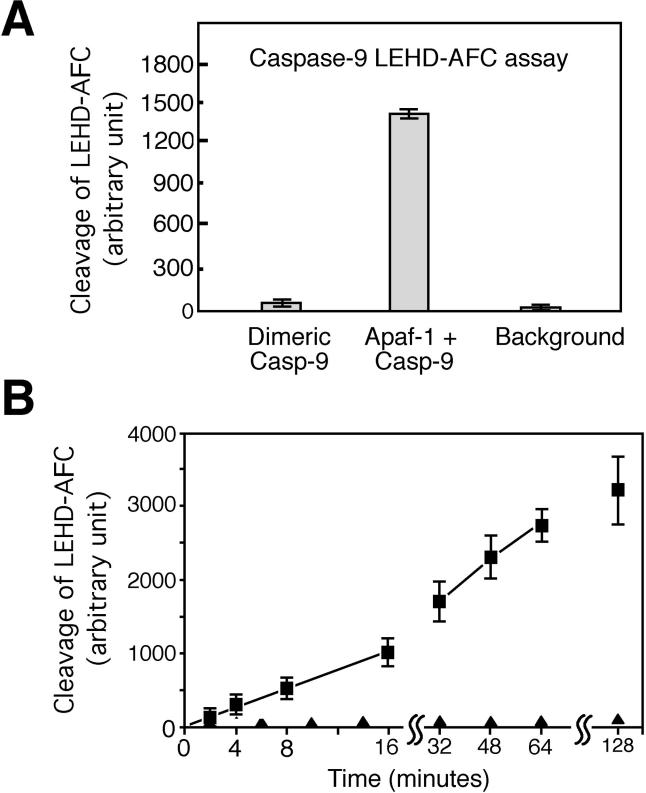
The Dimeric Caspase-9 Exhibits a Much Lower Activity Than the Apaf-1-Activated WT Caspase-9(A) Using fluorescent substrate LEHD-AFC, the catalytic activity of the Apaf-1-activated WT caspase-9 was approximately 35-fold greater than that of the dimeric caspase-9.(B) A time course comparison of the catalytic activities between the Apaf-1-activated WT caspase-9 and the dimeric caspase-9. WT and dimeric caspase-9, 0.5 μM; Apaf-1 (residues 1–570), 2 μM; LEHD-AFC, 200 μM.